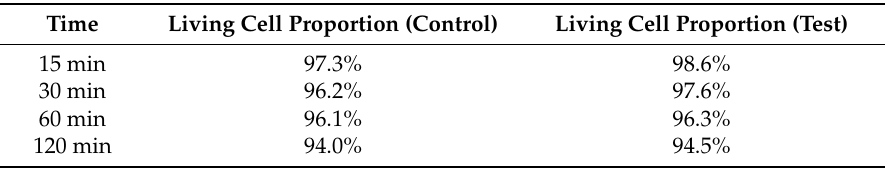
Table A1. Cell viability assay results.